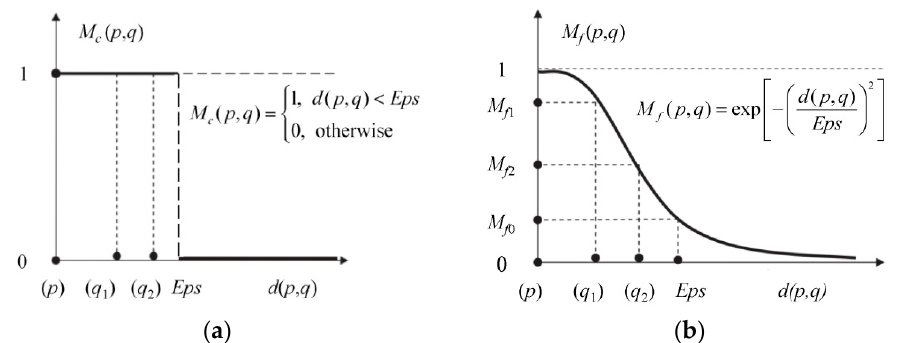
Figure 3. Membership functions: ( a ) binary type; ( b ) exponential type.